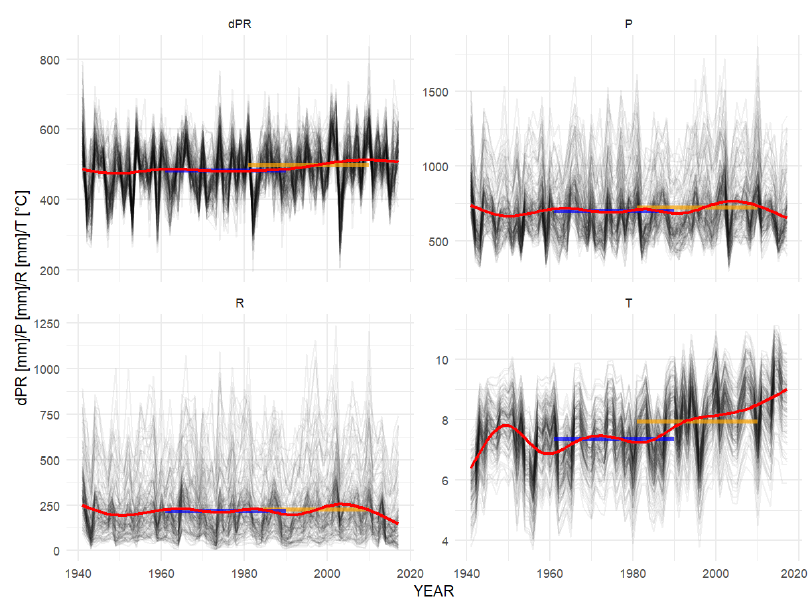
Figure 3. The difference between precipitation totals and runoff (dPR), precipitation totals (P), runoff heights (R), and air temperature (T). Red: local polynomial regression; blue: average for 1961–1990; orange: average for 1981–2010; grey: yearly observation. The data gathered from 334 water gauging stations and 133 meteorological stations.